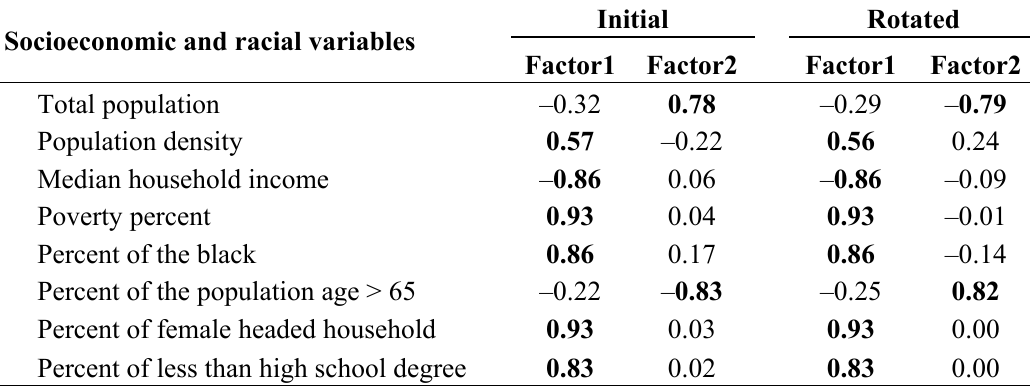
Table A2. Groupings of socioeconomic and racial variables determined by factor analysis.